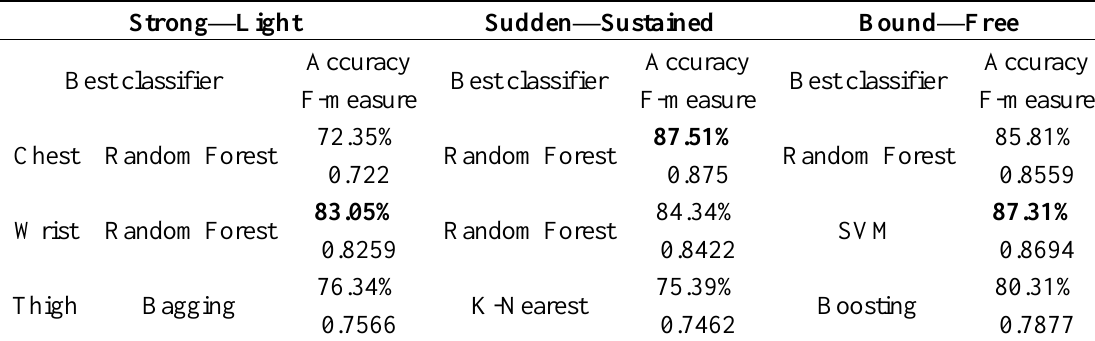
Table 7. The accuracy and the F-measure value for the best classifiers for acceleration data obtained from each location.